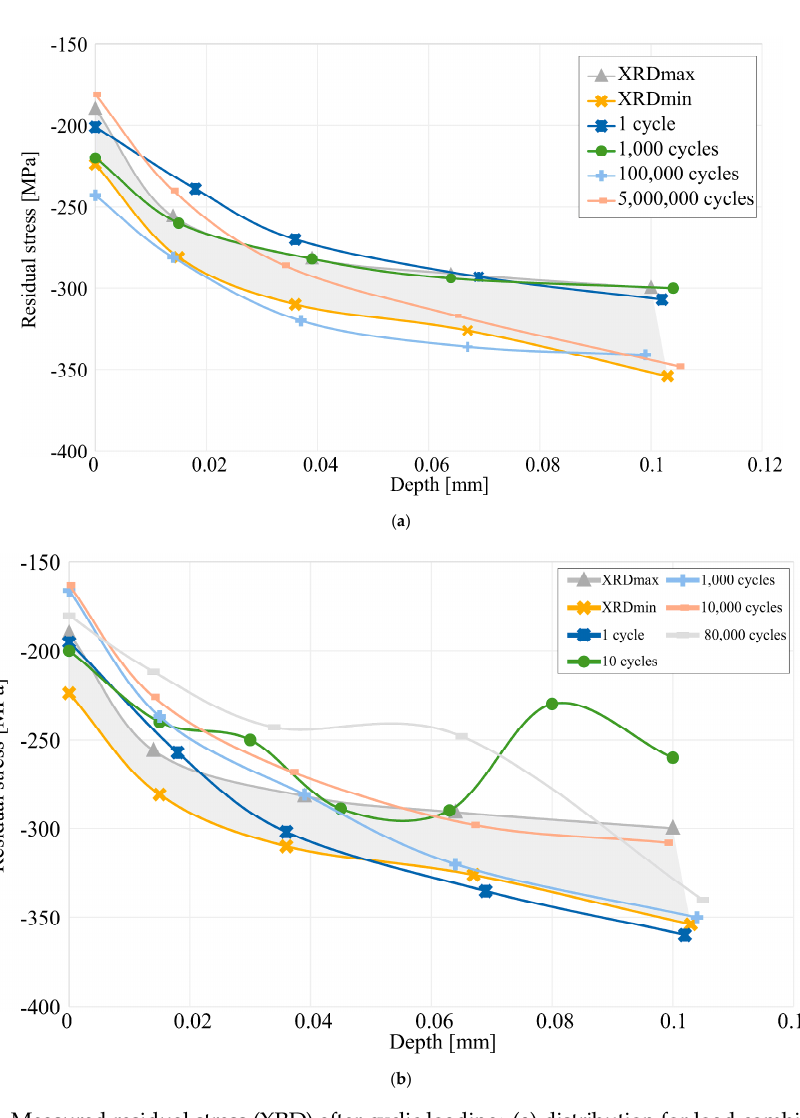
Figure 17. Measured residual stress (XRD) after cyclic loading: ( a ) distribution for load combination σ = 70 MPa, Q = 971 N, N = 6629 N; ( b ) distribution for load combination σ = 175 MPa, Q = 2113 N, N = 5429 N.